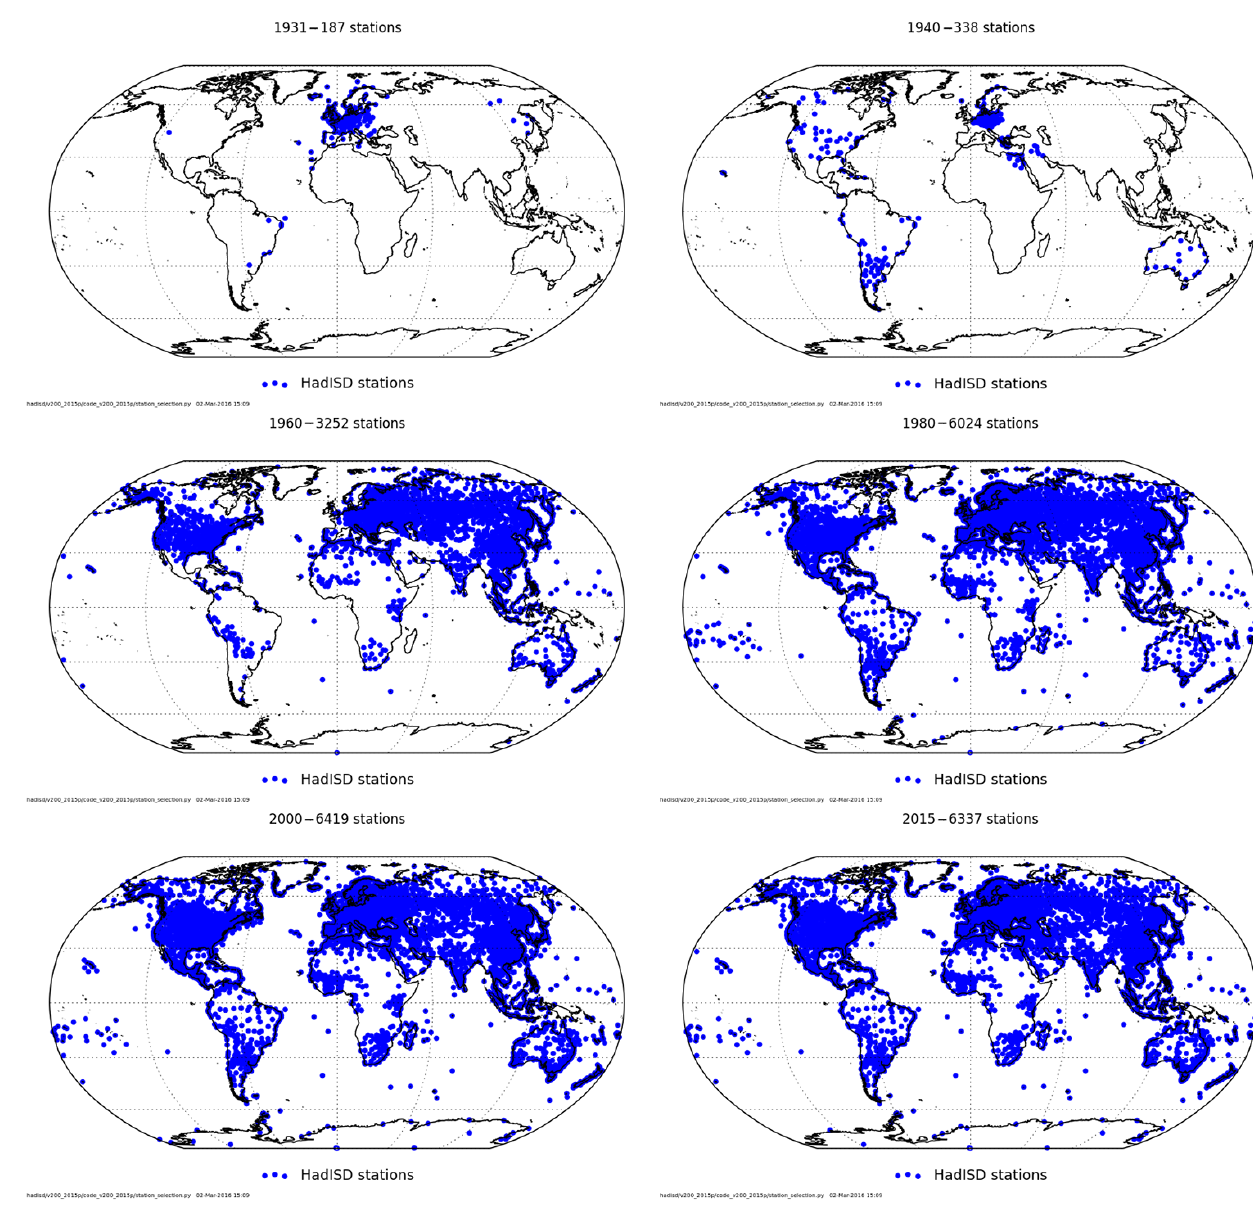
Figure A1. The distribution of stations across the globe in six years (1931, 1940, 1960, 1980, 2000 and